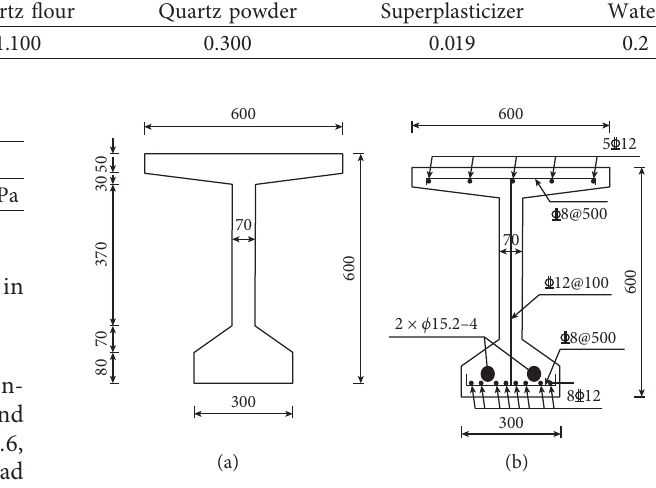
Figure 10: (a) Test beam section. (b) Longitudinal reinforcement layout (mm). Table 3: Mechanical properties of